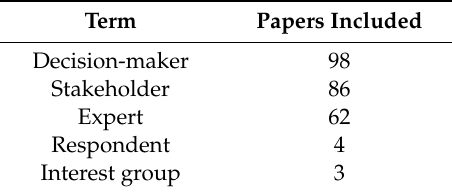
Table 6. Terminology employed.